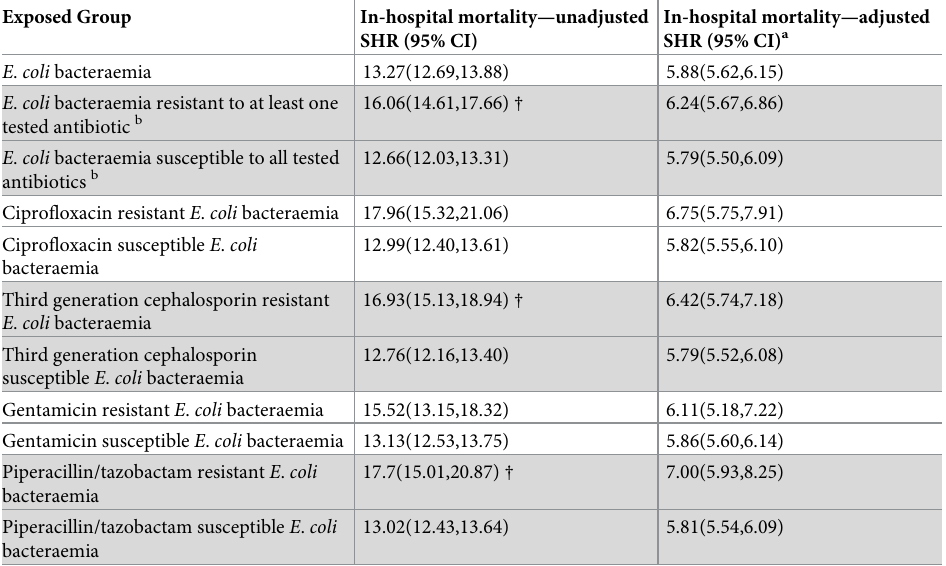
Table 3. Daily subdistribution hazard ratios for in-hospital